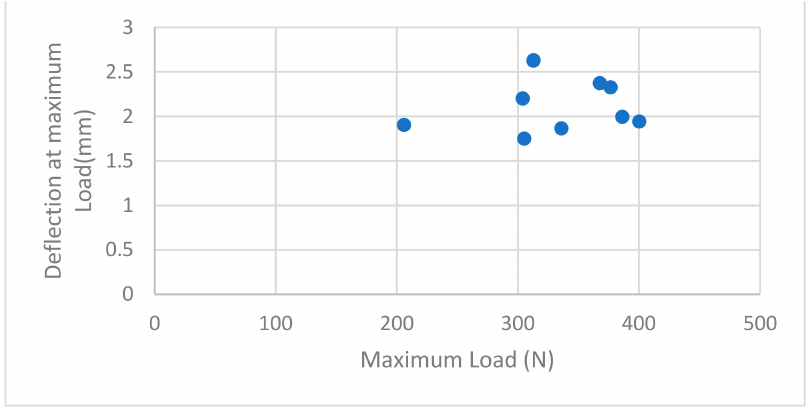
Figure 6. Maximum deflection with maximum load applied to zirconia crowns with RPD